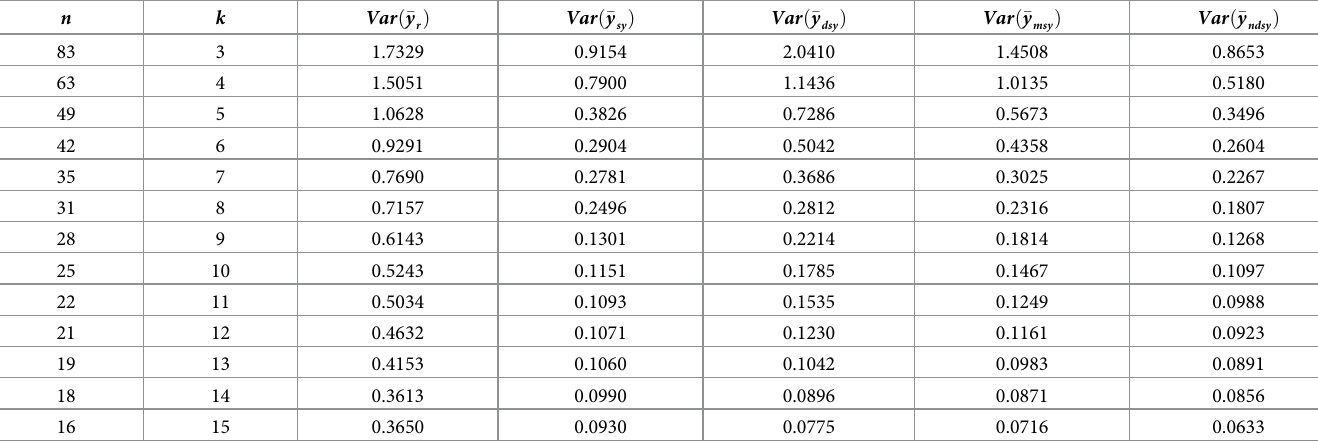
Table 2. Variances of different sampling schemes for milk yield